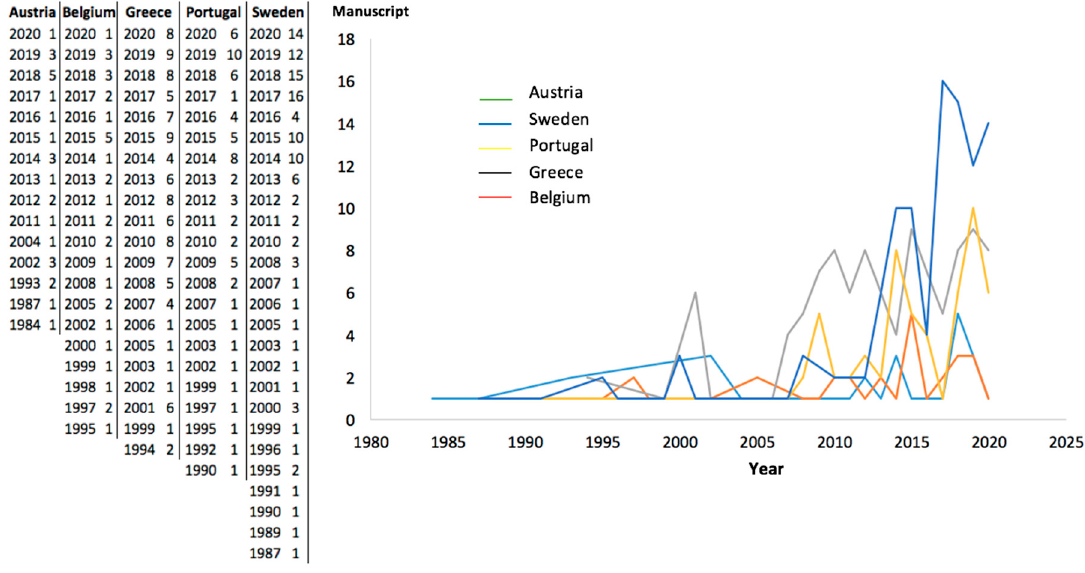
Figure 2. Documents by year.